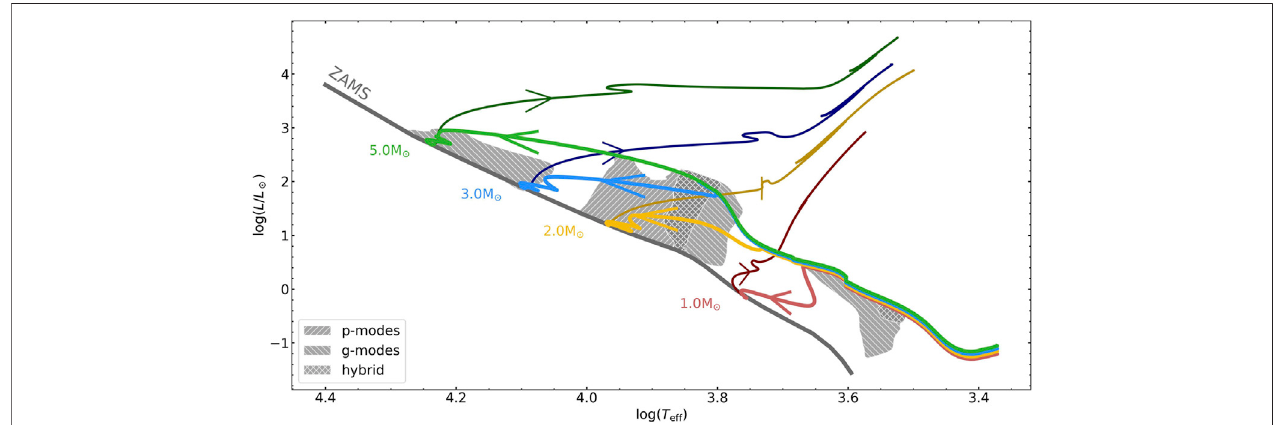
FIGURE 4 | Evolutionary tracks for the protostellar seed until the asymptotic giant branch. The colored lines show the evolution of stars with different masses between 1 and 5 M ⊙ . The pre-main sequence evolution is shown in brighter colors compared to the main- and post-main sequence evolution. Evolutionary tracks are shifted slightly at the beginning of the evolution for better visibility. The zero age main sequence is shown as grey line and the instability regions (i.e., the same as in Figure 3 ) are shown in grey with hashes according to the